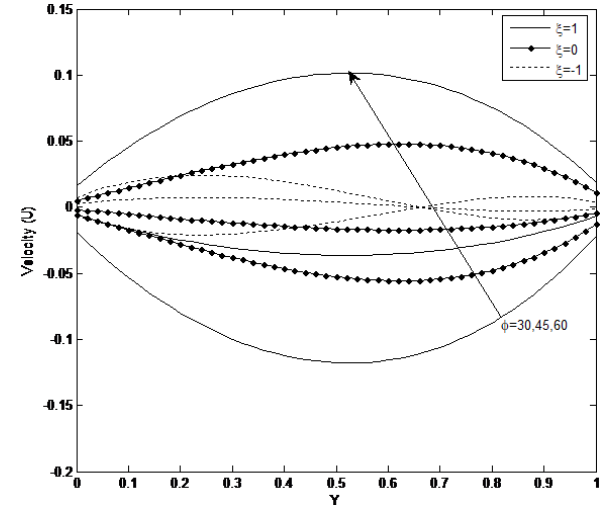
Fig. 2: Effect on angle of inclination on velocity profile